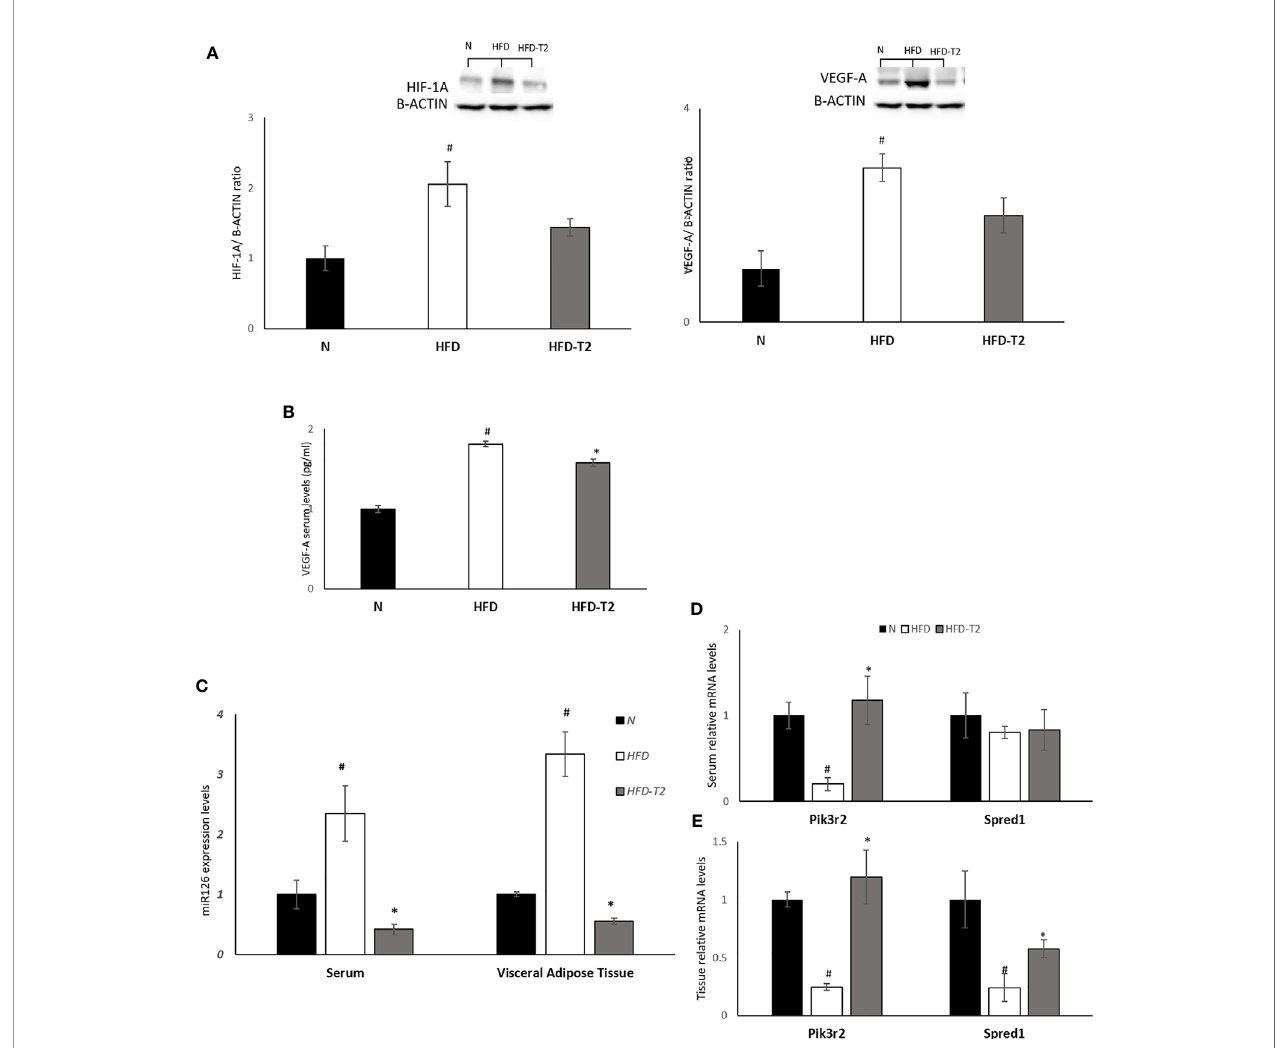
FIGURE 7 | Effects of T2 administration on HIF-1A and VEGF-A expression in vWAT and on miR126 and of its targets PIK3R2 and SPRED1 in serum and vWAT. (A) Western blot image and densitometry showing relative expression of HIF-1A and VEGF-A in vWAT. Representative blots are shown; (B) VEGF-A was detected by a competitive Enzyme Linked-Immunosorbent Assay (ELISA) in serum of N, HFD, HFD-T2 rats. (C) qPCR analysis of miR126 in serum and vWAT of N, HFD, and HFD-T2 rats; (D) qPCR analysis of PIK3R2 and SPRED1 in serum of N, HFD, and HFD-T2 rats; (E) qPCR analysis of PIK3R2 and SPRED1 in vWAT of N, HFD, and HFD-T2 rats. The histograms represent means ± SEM of fi ve independent experiments (n = 5), # P < 0.05 vs. N; * p < 0.05 vs. HFD. N: rats receiving a standard diet for 14 weeks; HFD: rats receiving a HFD for 14 weeks; HFD-T2: rats receiving a HFD for 14 weeks with a daily administration of T2 during the last 4